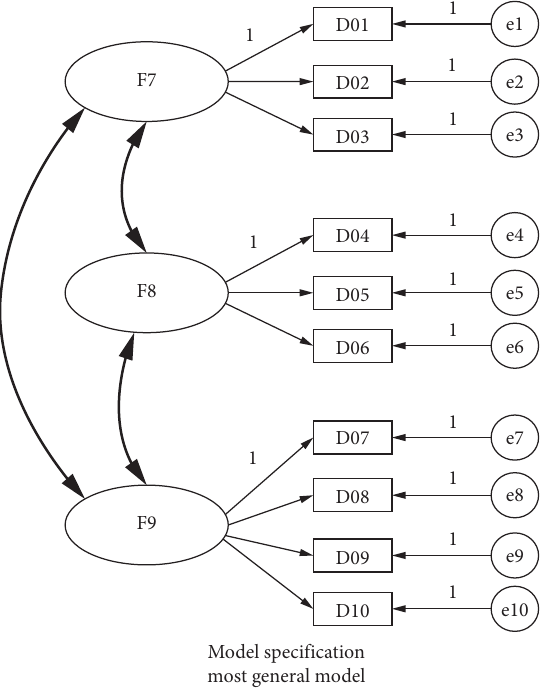
Figure 3: Theoretical SEM model of the external